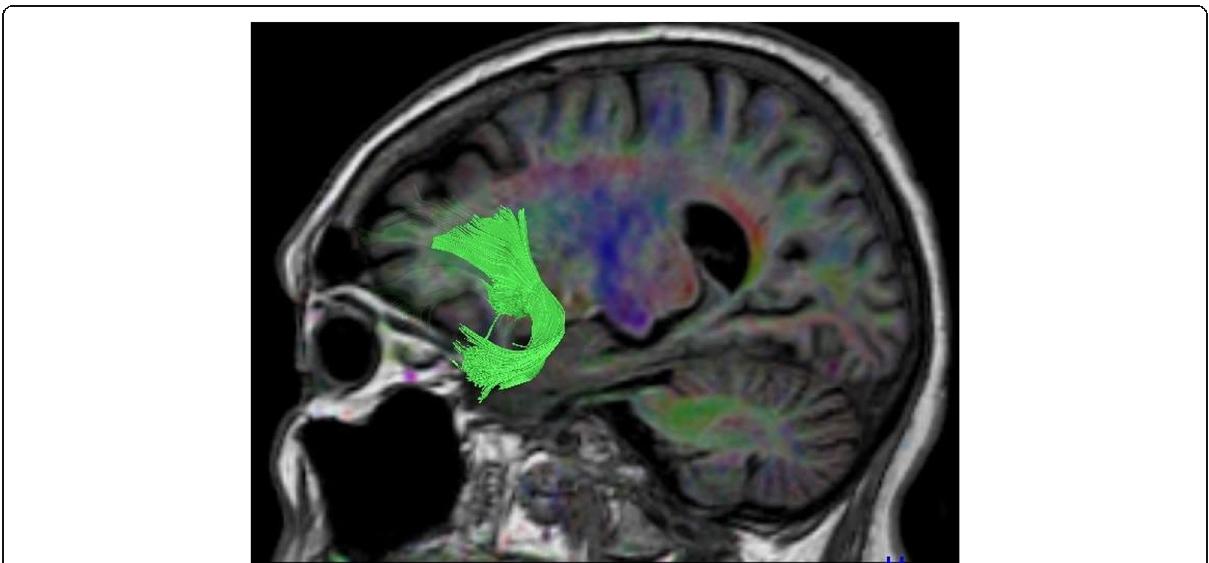
Fig. 1 Sagittal view of the detailed tractography of the right uncinated fasciculus (UNC) in a normal subject. Color coding is included to assist with identification of the fibers in the images. Fractional anisotropy (FA) and mean diffusivity (MD) are (0.50 ± 0.140) and (0.61 ± 0.198) respectively